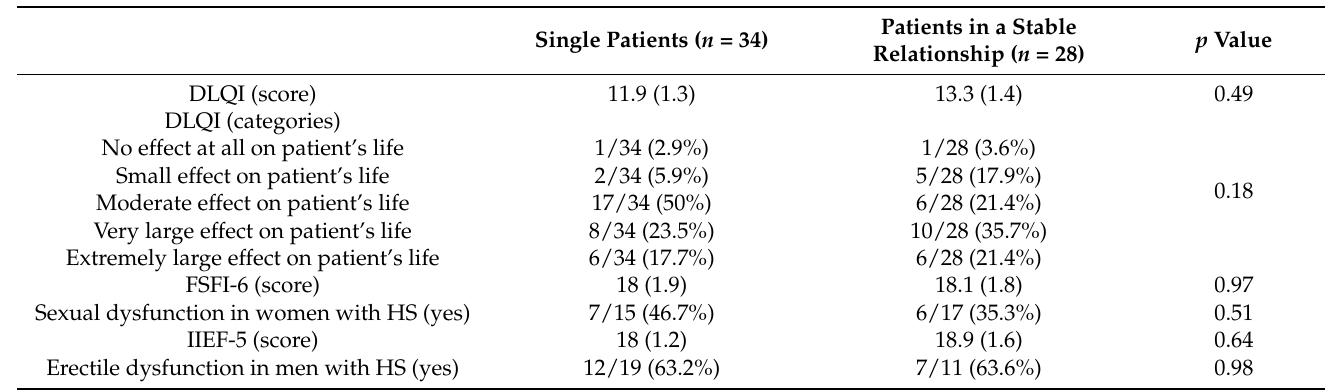
Table 2. Quality of life and sexual function in patients with HS.